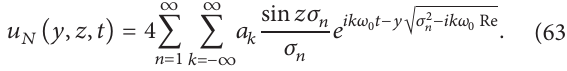
Figure 2: The influence of the fractional-order parameter 𝛼 on the velocity profile 𝑢 1 (𝑦,𝑧, 𝑡) with 𝑧 = 0.5 , 𝑡 = 0.3 , 𝛽 = 0.8 , Re = 1 , = 5 , 𝜆 = 2 , and 𝜆 = 1 . 𝜆 1 2 3